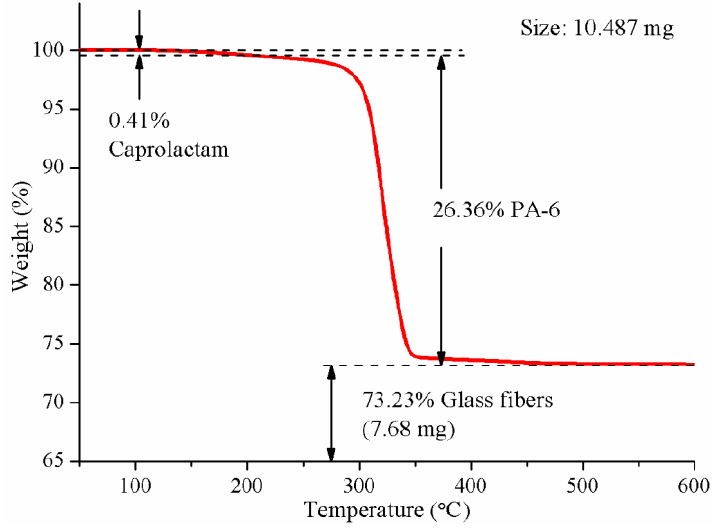
Figure 8. A typical TGA diagram of the composites pultruded with heating zone temperature of 180 °C.